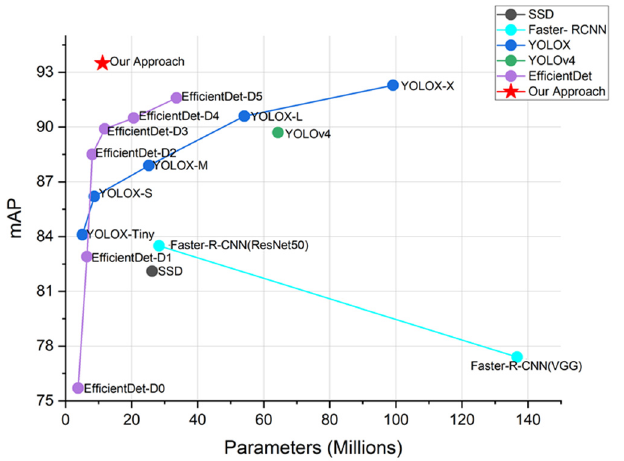
Figure 12. Model size vs. mAP. Details are in Table 4. Note that our approach obtains higher accu- racy while having less model complexity.